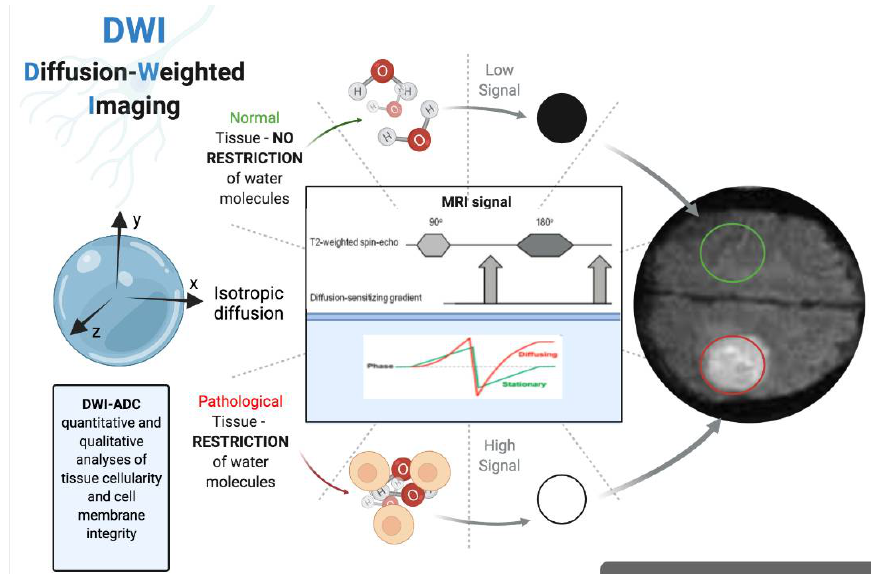
Figure 2. Physical principles of diffusion-weighted imaging (DWI). The figure was created with